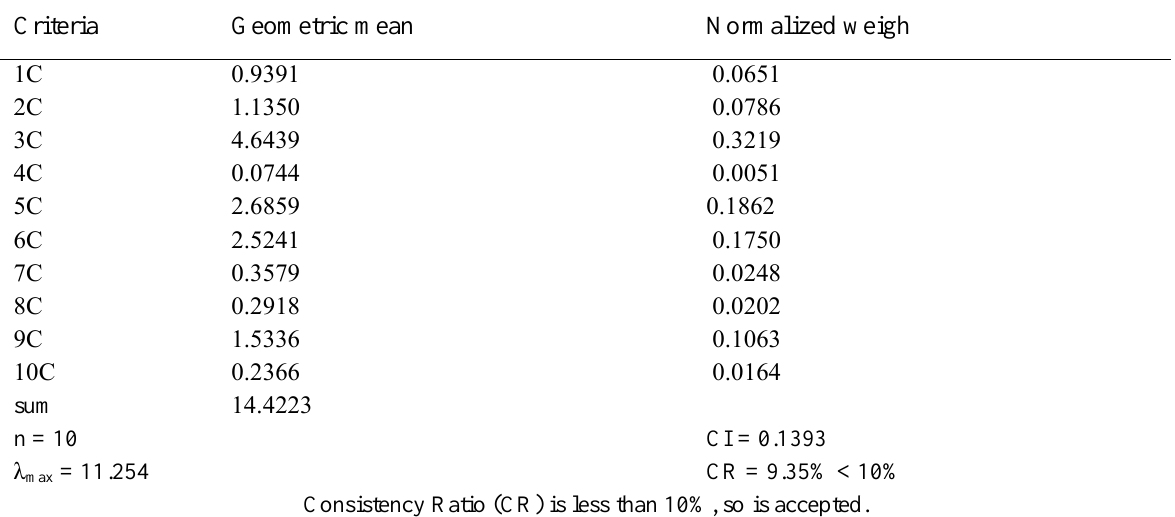
Table 4. The Matrix of Geometric Mean and Normalized Weight for all